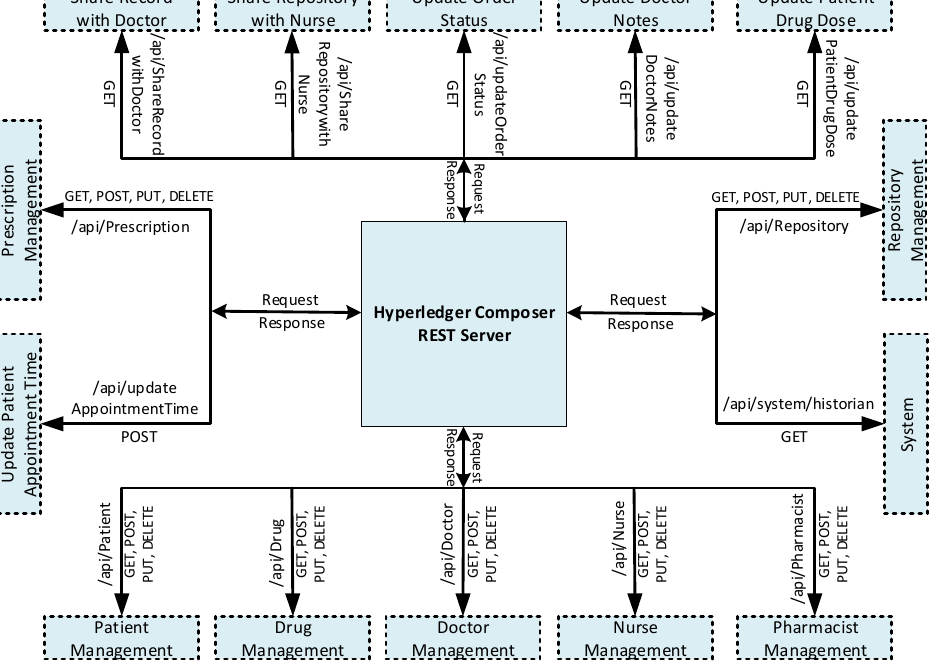
Figure 13. Hyperledger Fabric-based business network for the proposed